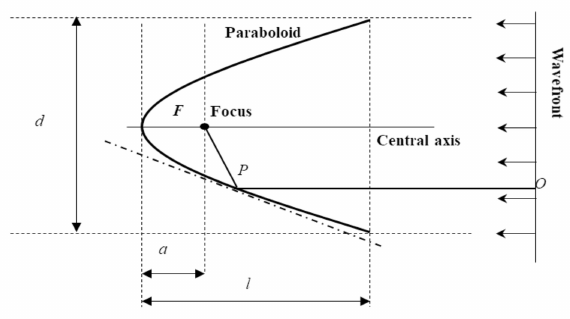
Figure 1. Geometry of parabola and parallel incident waves.